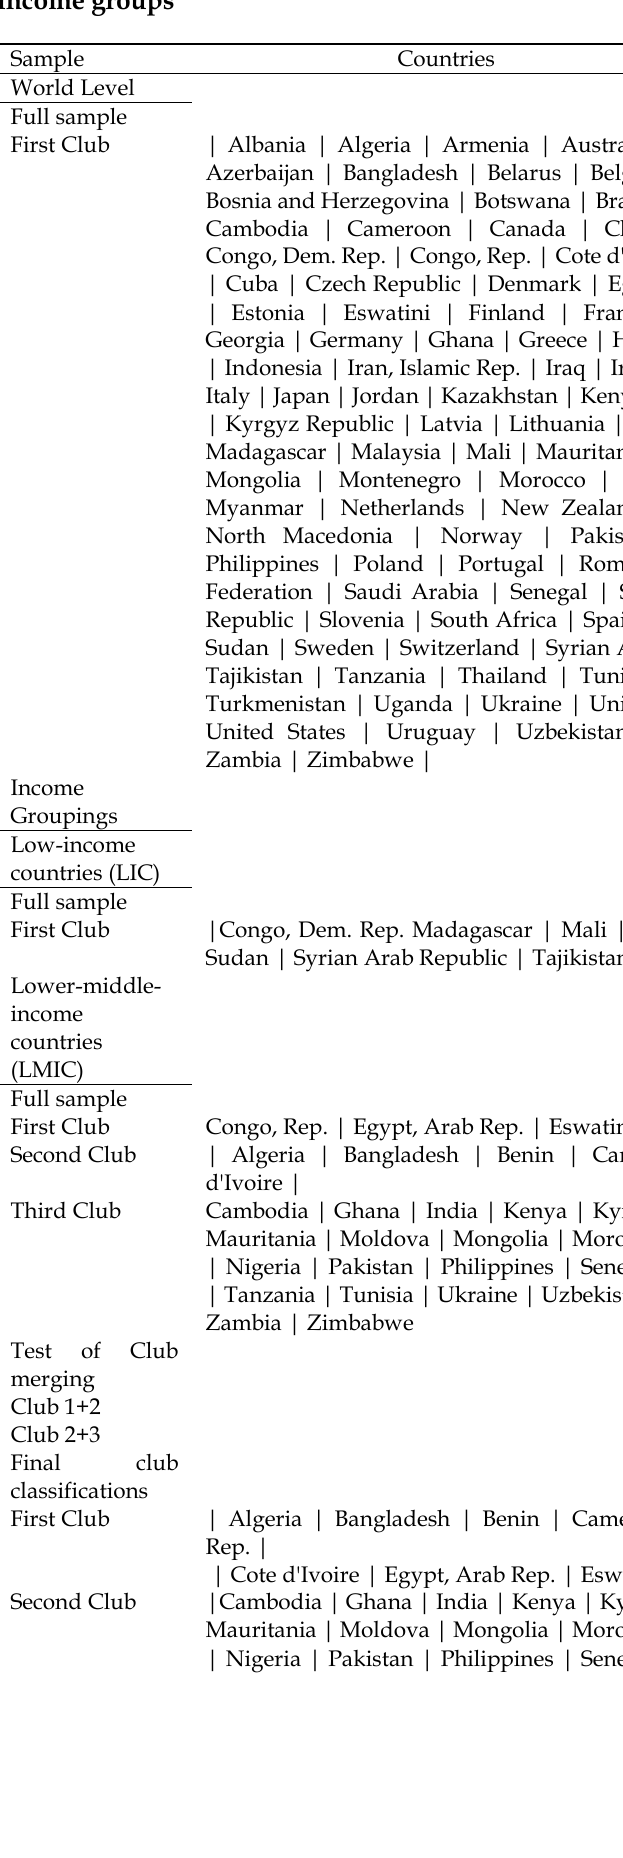
Table 4: Transportation and final club convergence results (club merging) for the world and four income